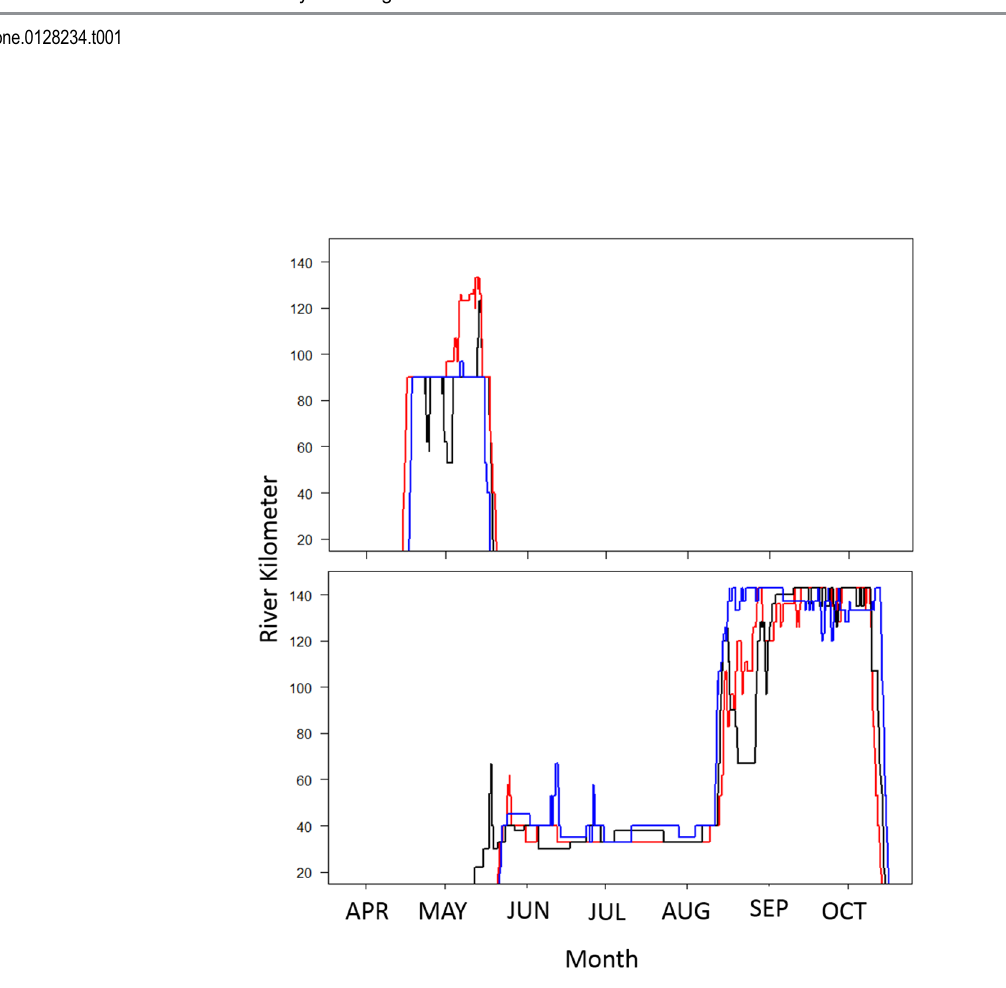
Fig 2. The telemetry movements (2012 black, 2013 red, and 2014 blue) of mature male Atlantic Sturgeon repeatedly returning to the James River, VA. The top panel (A) is the only telemetered spring sturgeon (tagged in 2012) and the bottom panel (B) is a representative displaying the typical behavior of fall- run sturgeon. The fall-run male was tagged in September of 2011 at rkm 120.